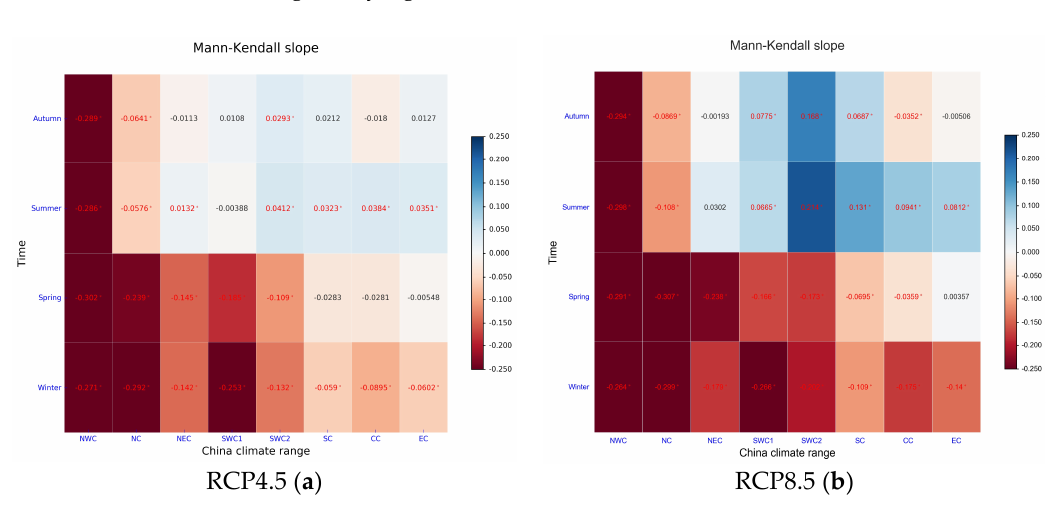
Figure 6. Heatmap of the projected four seasons based on Sen’s slope estimates for decadal SPEI_3 changes during the period 2000–2100 over eight subregions, defined by Table 1, using MME under two scenarios. The slope with the red color and star symbol indicates that the Mann–Kendall trend is statistically significant at the 5% level.